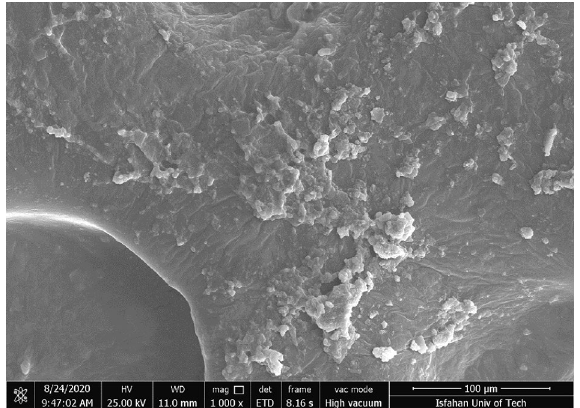
Figure 1. FESEM image of bee carcasses with 1000 X magnification.